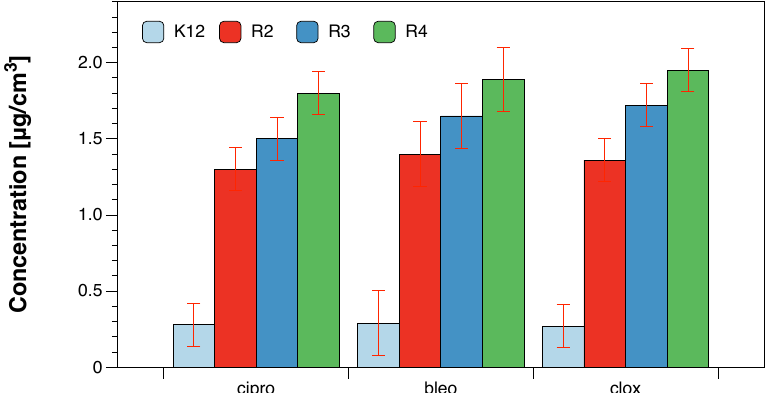
Figure 6. Examples of MIC with model bacterial strains K12, R2, R3, and R4 with ciprofloxacin, bleomycin, and cloxacillin. Each experiment was performed independently in three replications (n = 3).